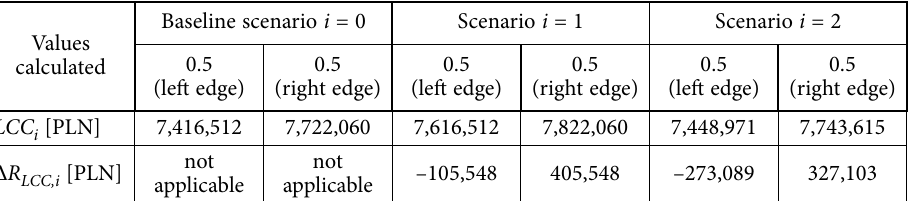
Table 8. Values calculated in the section α =